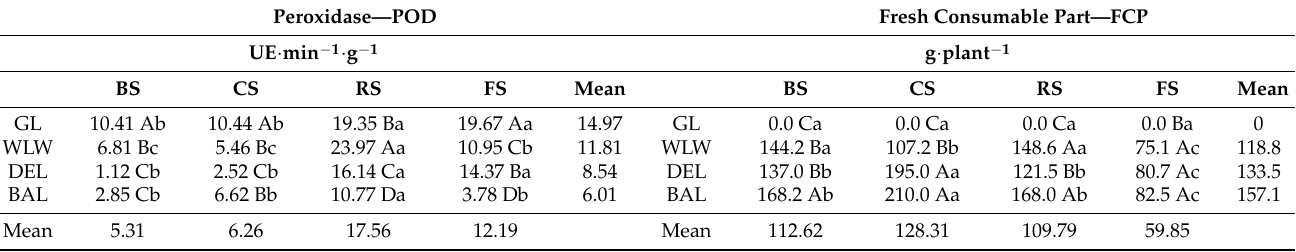
Table 4. Activity of enzyme peroxidase (POD) and fresh consumable part (FCP) of iceberg lettuce cultivars under different shade screens.